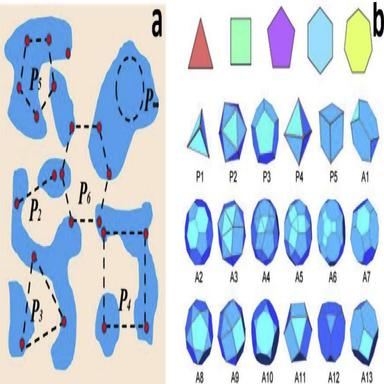
(a) Schematic illustration of stochastic events contributing to the Pn functions in the case of regular polygons. (b) Examples of regular polygons (triangle, square, pentagon, hexagon, and decagon) and polyhedra (including the Platonic solids P1eP5, and Archimedean solids A1-A13) for computing the Pn functions.